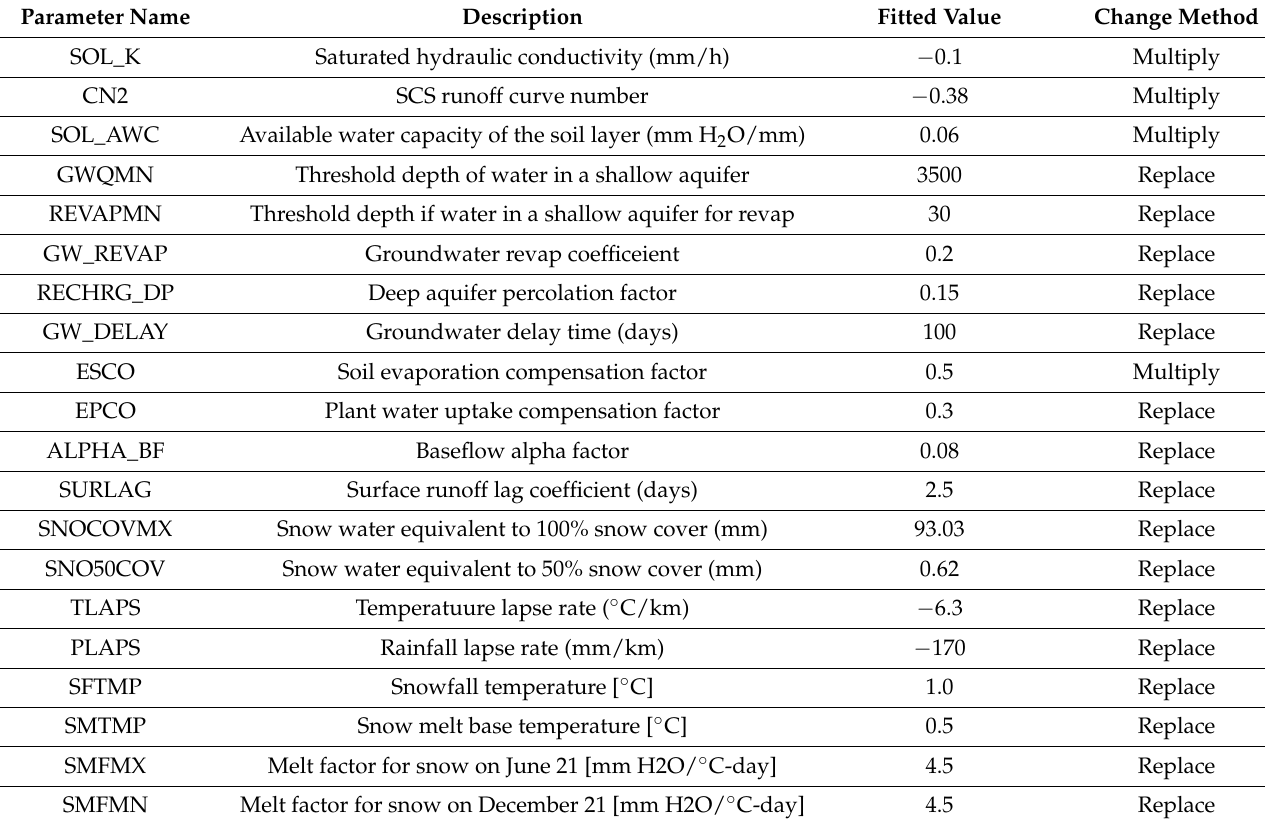
Table 4. Parameters, their fitted value, and mode of changing the parameters used in the SWAT